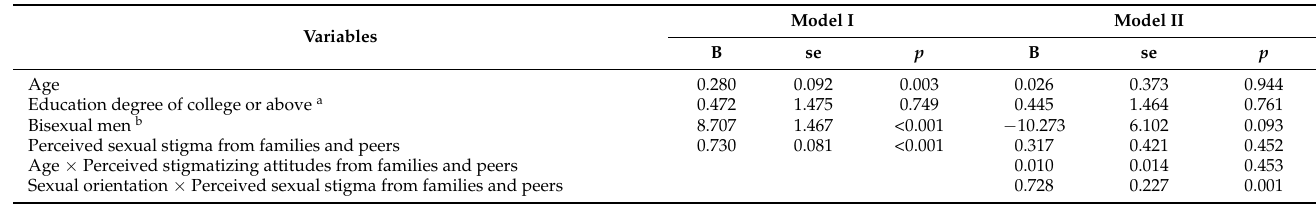
Table 2. Factors related to internalized homonegativity: multivariate linear regression